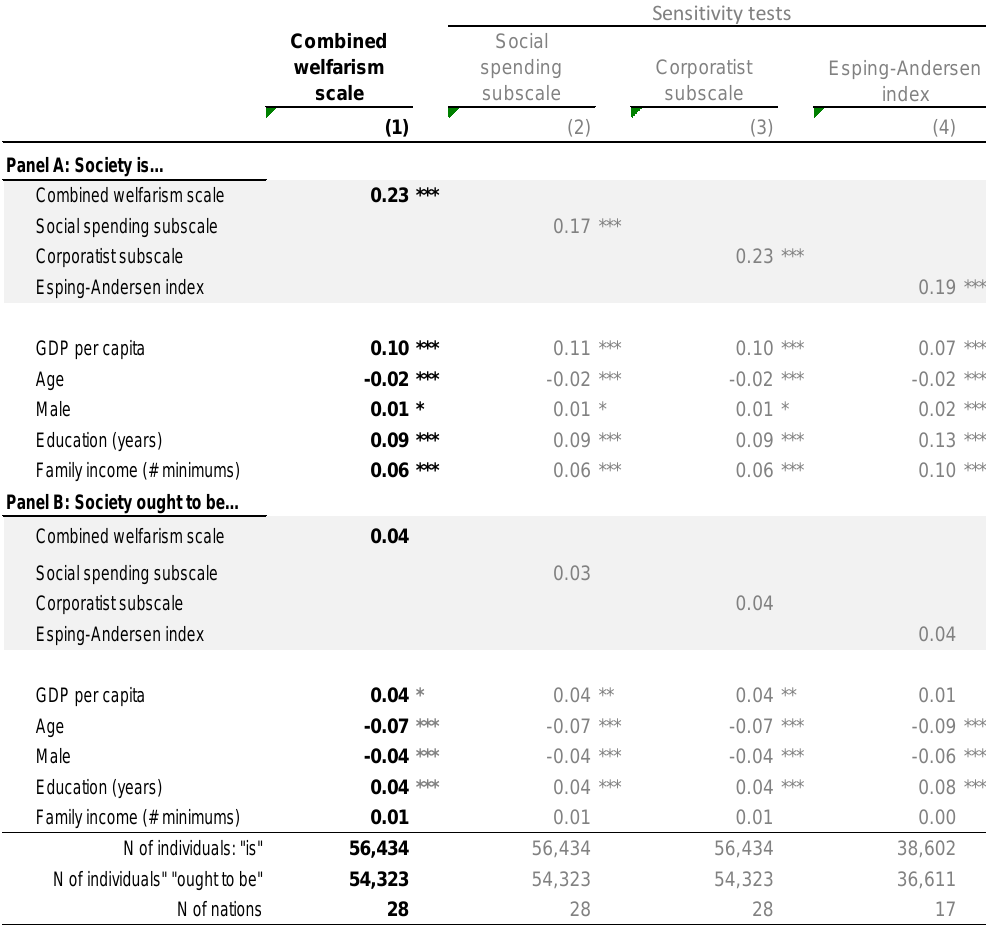
Figure A8. Demographic and SES differences in images of how egalitarian society is (Panel A) and how egalitarian it ought to be (Panel B) are small regardless of which definition of welfarism is used. Multilevel regression results, standardized coefficients.